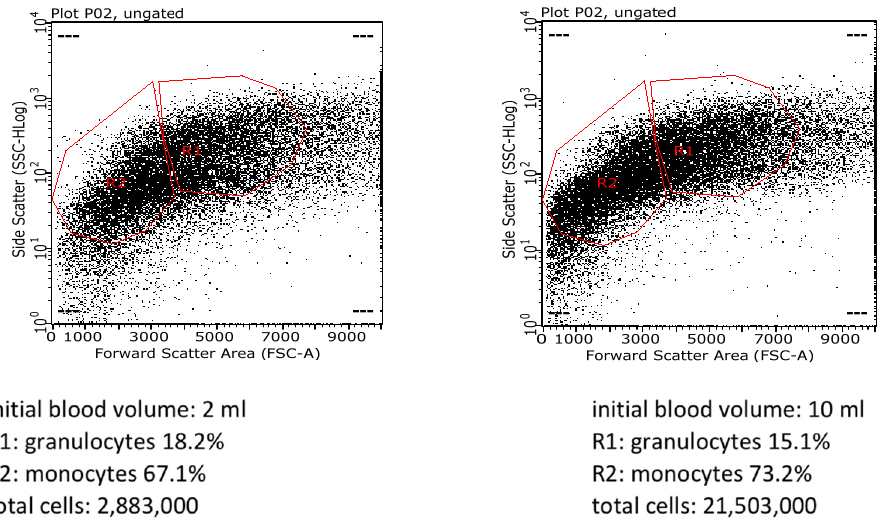
Figure 2. Flow cytometry analysis. ( Left ) Representative plot from 2 mL of initial blood volume (our new protocol); ( Right ) representative plot from 10 mL of initial blood volume (standard technique). (Data were acquired using the flow cytometer model Guava ® easyCyte 5 HPL Benchtop Flow Cy ‐ tometer (Merck Millipore, Burlington, MA, USA).